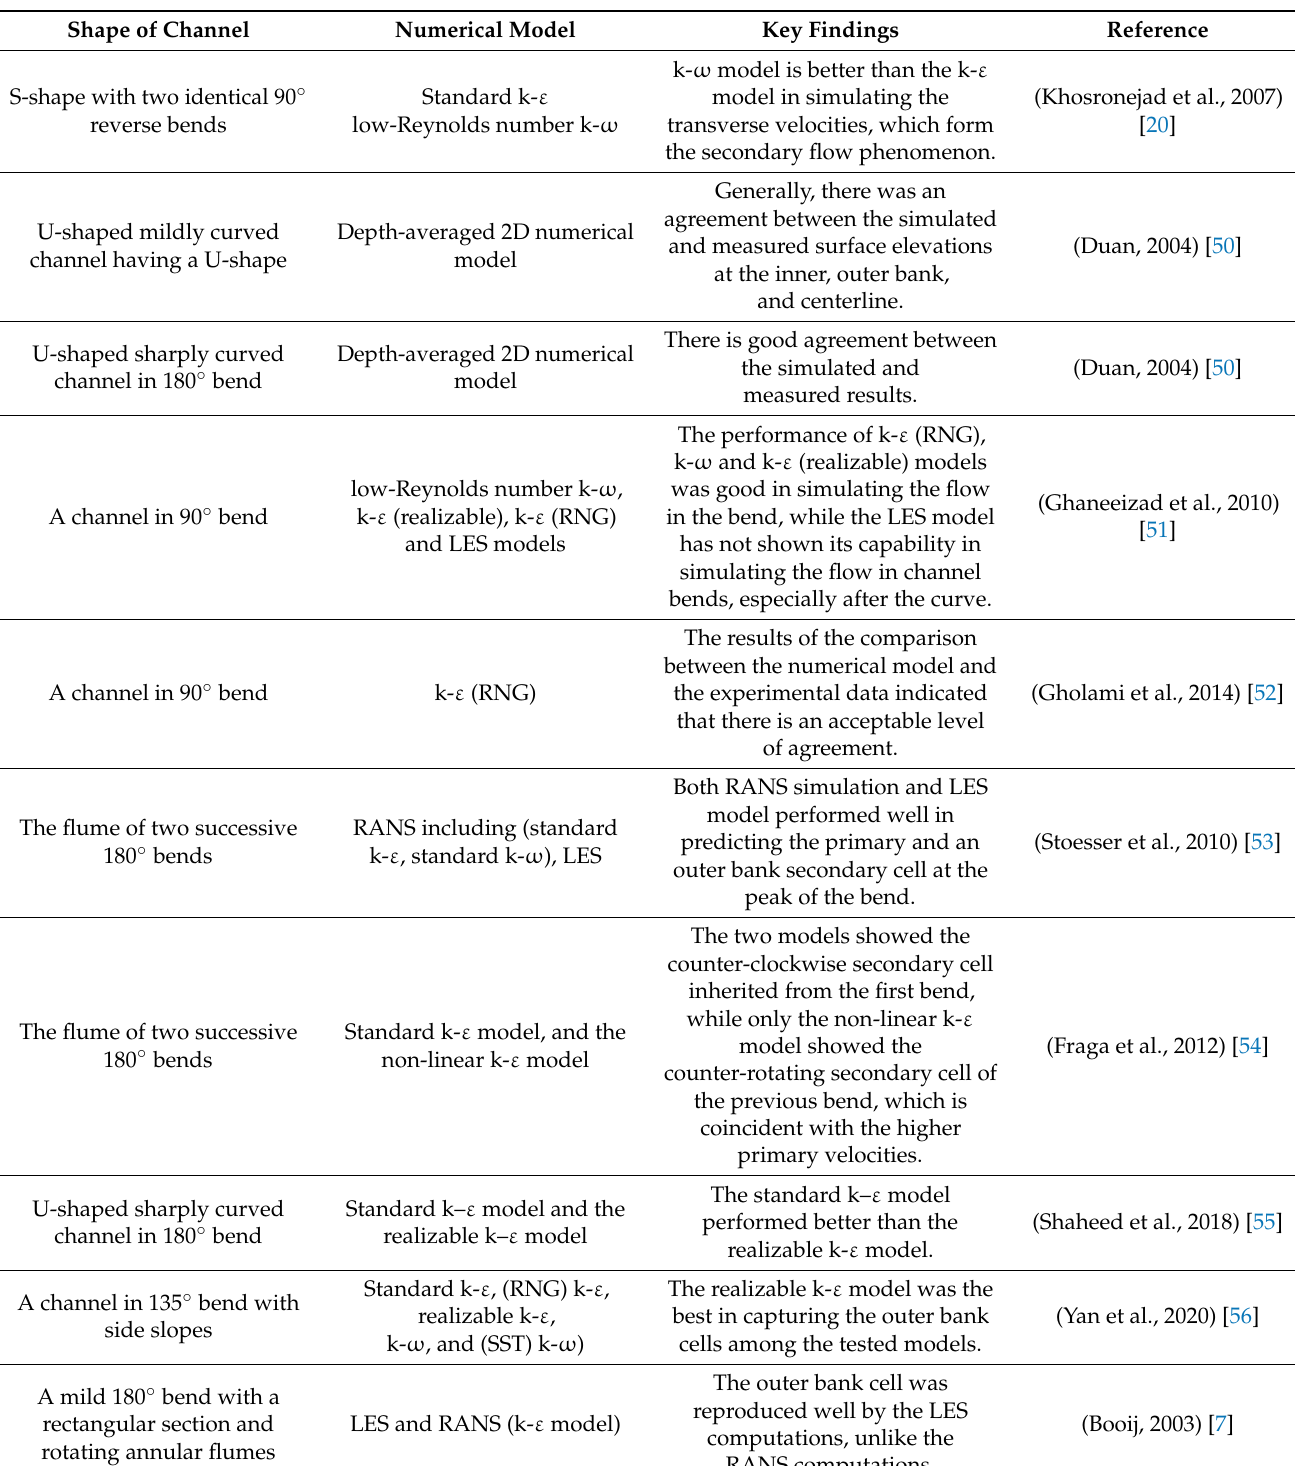
Table 1. Summary of selected studies about secondary flow in curved channels used in Section